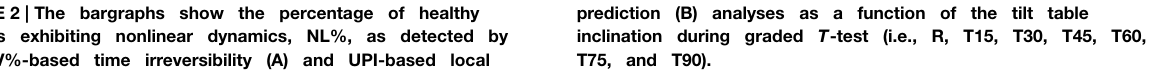
prediction (B) analyses as a function of the tilt table inclination during graded T -test (i.e., R, T15, T30, T45, T60, T75, and